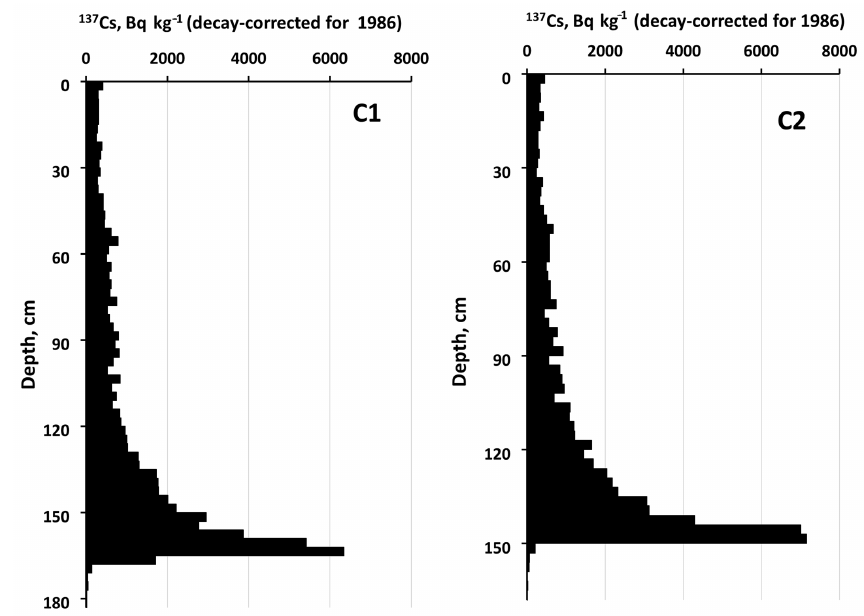
Figure 2. Vertical distribution of 137 Cs, decay-corrected for 1986, in the reservoir cores. The total inventory of 137 Cs in core C1 is 1030kBqm − 2 compared with 1160kBqm − 2 in core